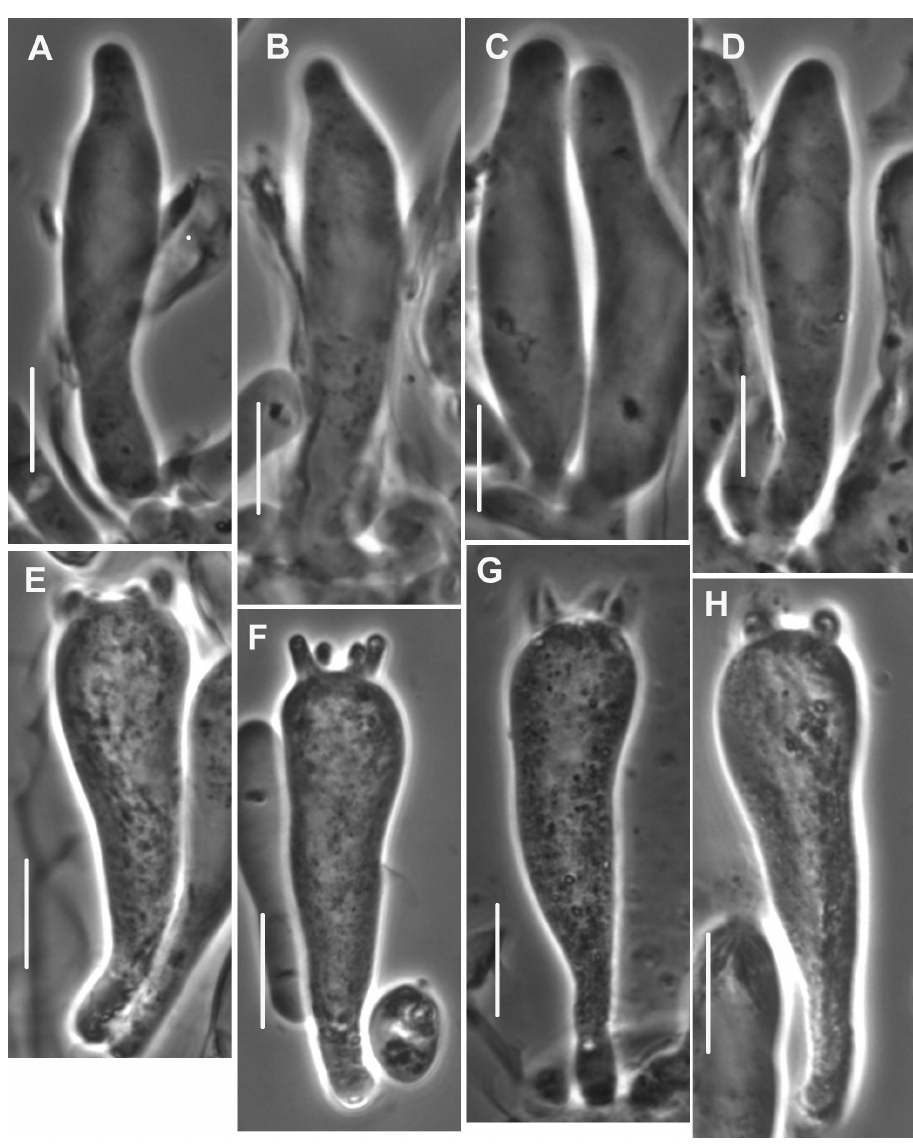
Figure 6. Mycetinis alliaceus . A–D Pleurocystidia. Note homogeneous contents. E–H Basidia. Note heterogeneous contents. Standard bars = 10 µm. TFB 11451